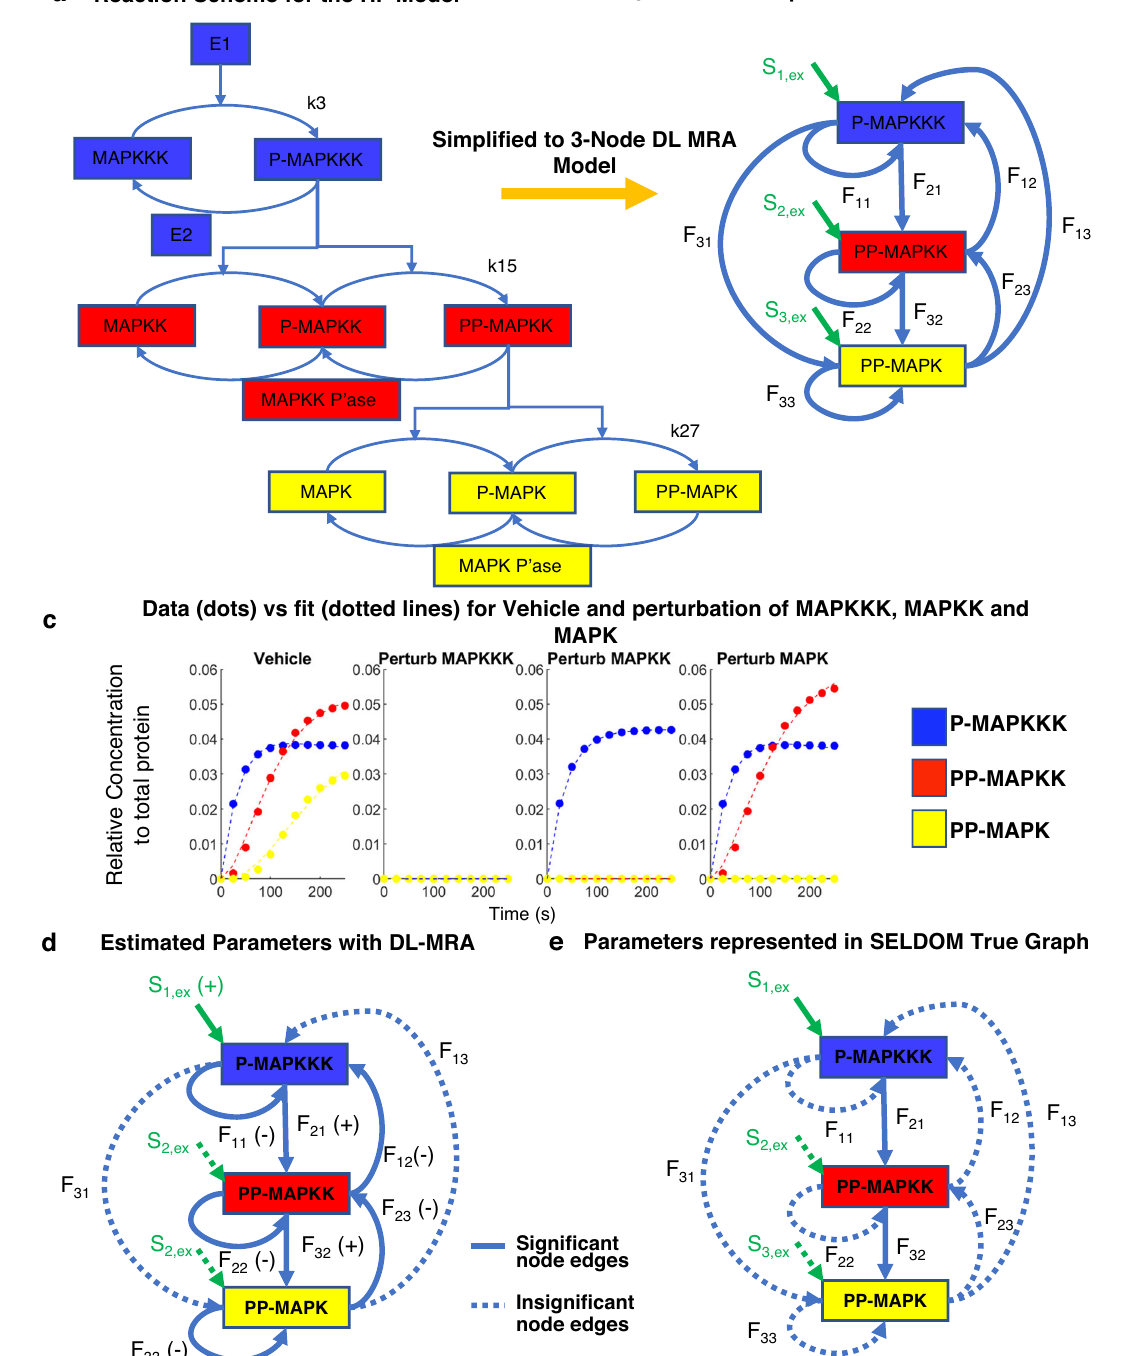
Fig. 4 Application to a signaling network. a Full Reaction scheme for the Huang – Ferrell (HF) Model, depicting the parameters k3, k15 and k27 which were perturbed sequentially to generate the perturbation data. b Model coarse-graining to a 3-node network. c Data generated for each node with a small E1 stimulus (2.5 × 10 − 6 uM). d Model parameters estimated as signi fi cant (bold) and negligible (dotted lines). e SELDOM true graph values represented in the 3-node model with parameters considered (bold) and not considered (dotted